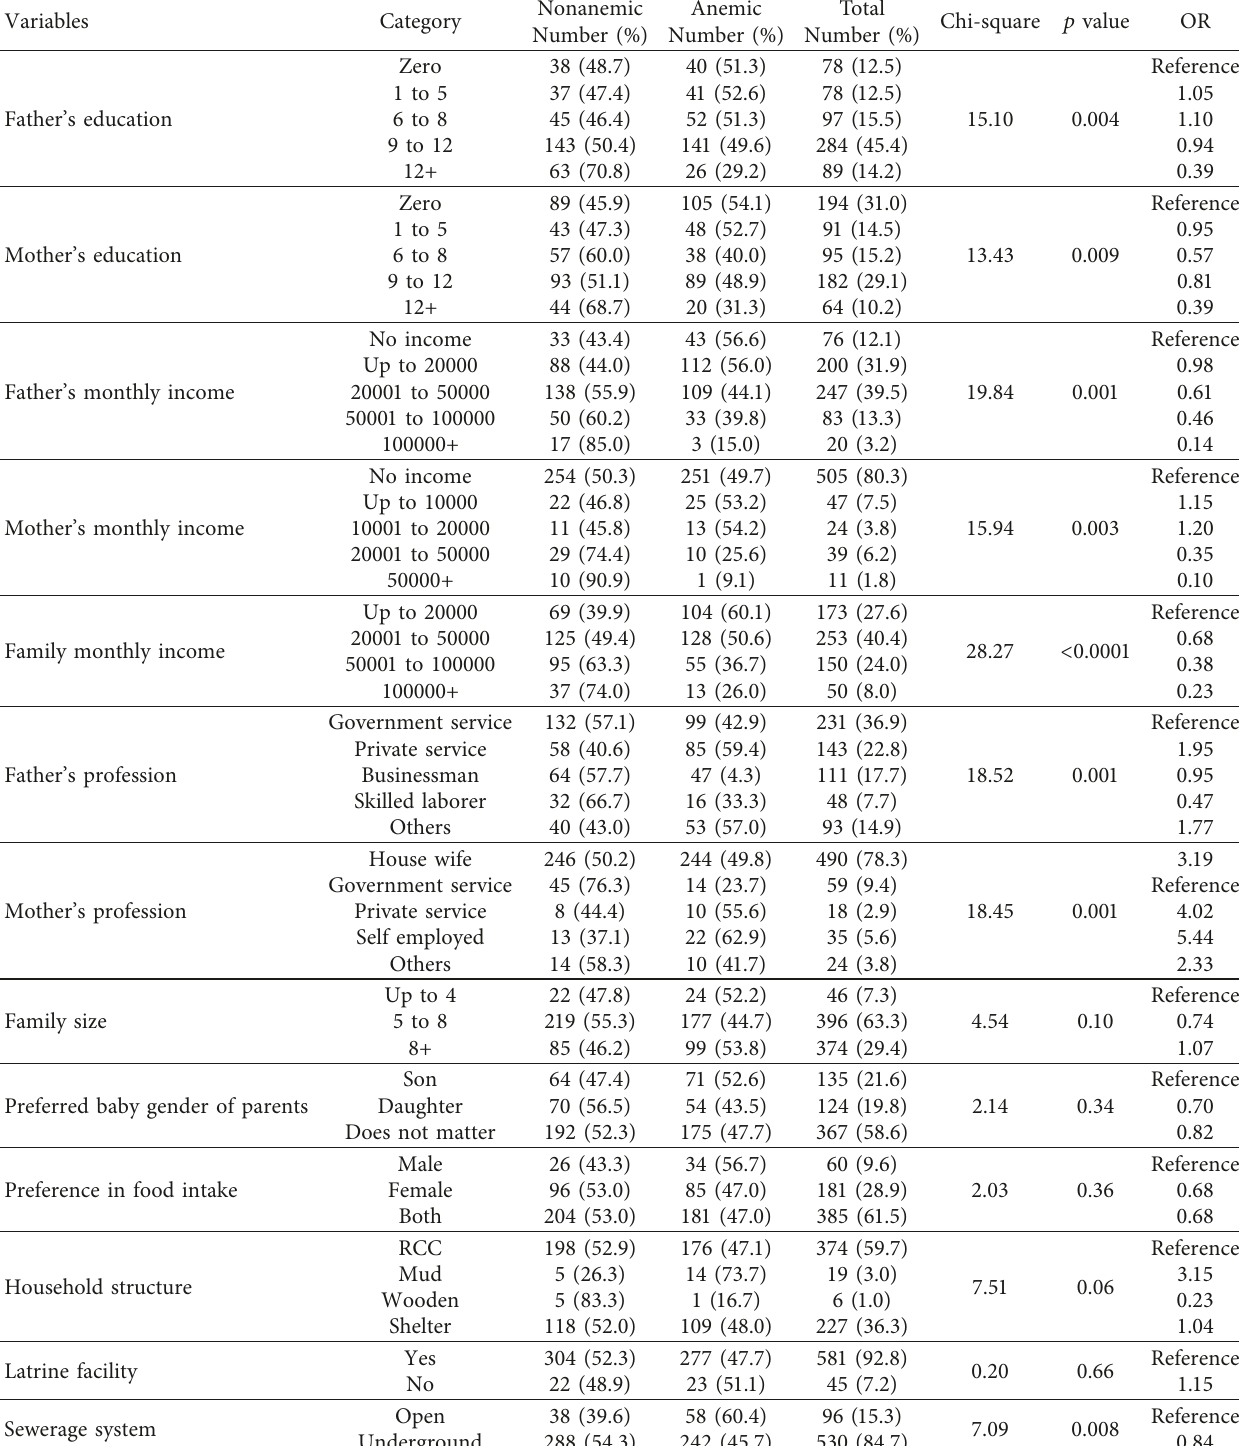
Table 3: Descriptive and bivariate analyses to reveal the parental and societal determinants of anemia and their association with the prevalence of anemia among adolescent